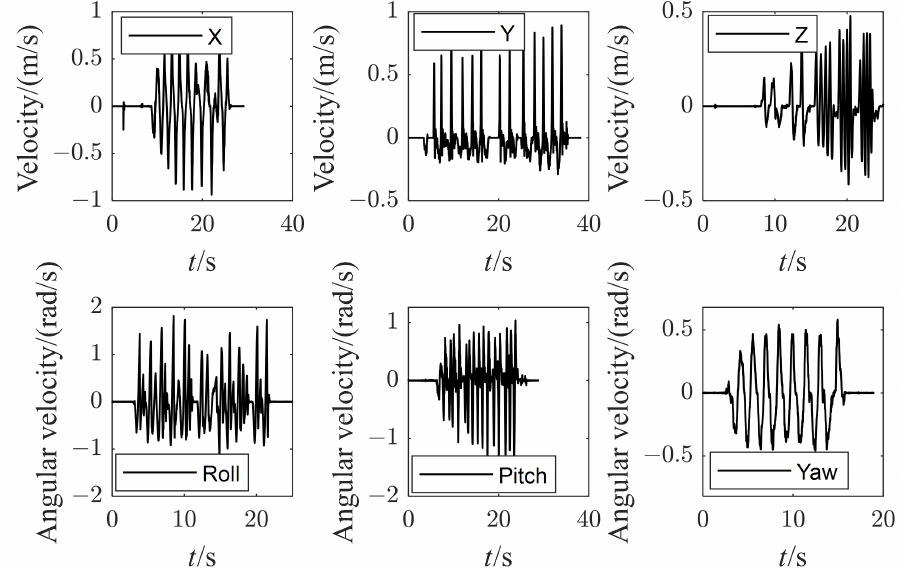
Figure 13. The measured velocity of the right foot with each